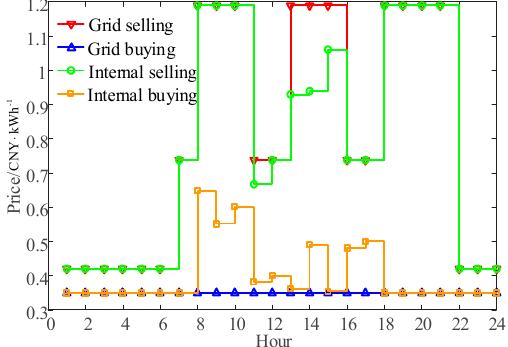
Figure 5. Comparison of internal prices and grid prices.